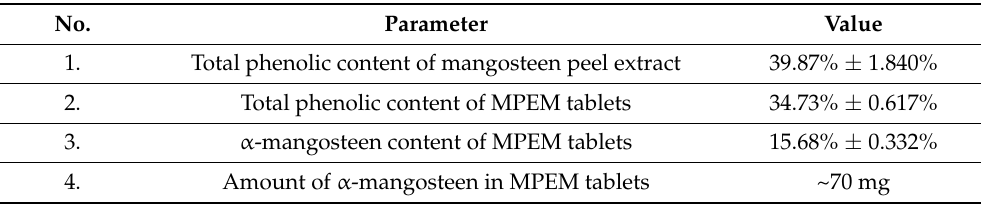
Table 4. Total phenolic and α -mangosteen content of mangosteen peel extract, mangosteen peel extract microcapsules, and their tablets.